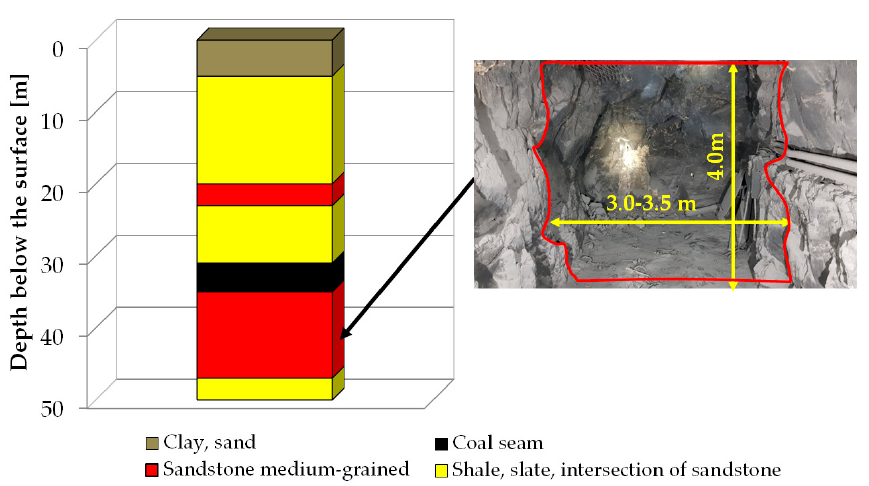
Figure 1. Stratigraphic profile of the GIG Experimental Mine ‘Barbara’.